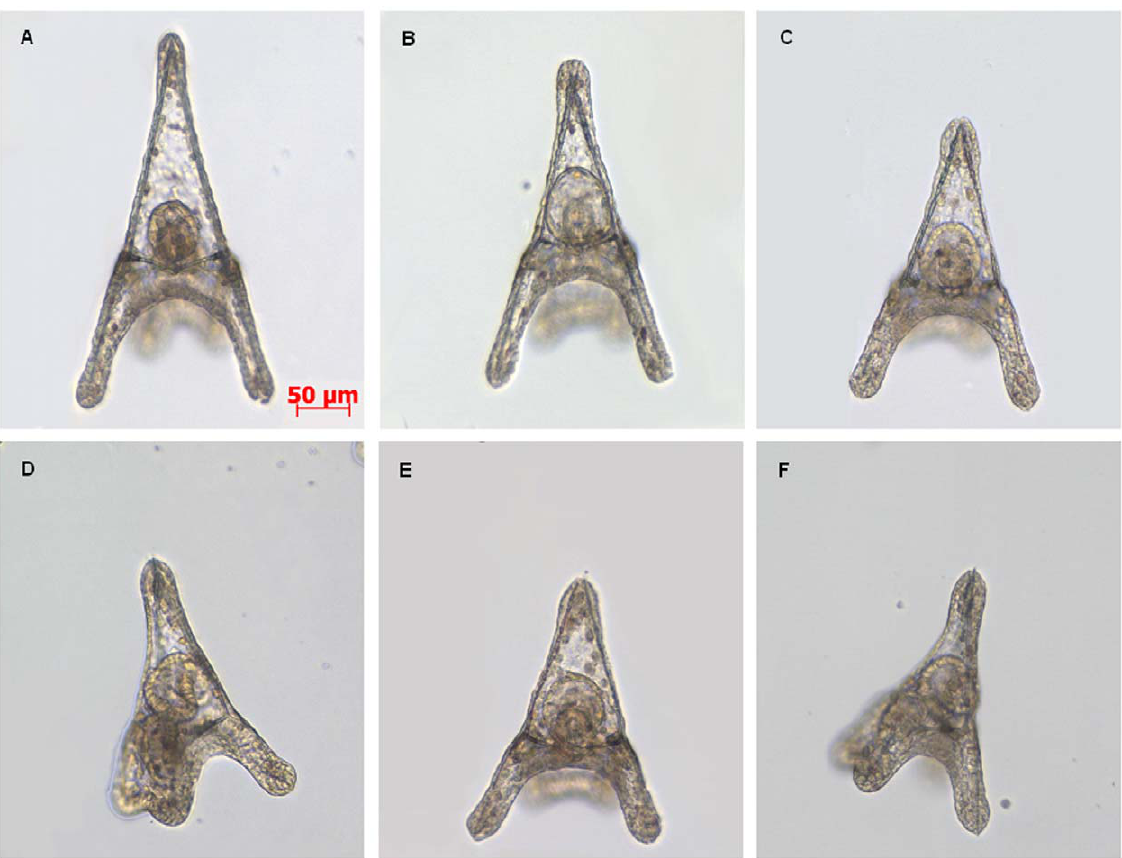
Figure 3. Dose-dependence effects of decadienal on sea urchin morphogenesis. (A) Control (embryos in sea water without decadienal), length 364.3 m m. (B) decadienal 0.15 m g/ml, length 317.6 m m, (C) decadienal 0.20 m g/ml, length 288.3 m m, (D) decadienal 0.25 m g/ml, length 261.6 m m, (E) 0.30 m g/ml, length 260.3 m m, (F) decadienal 0.35 m g/ml, length 253.6 m m. The images were taken at 48 hpf.